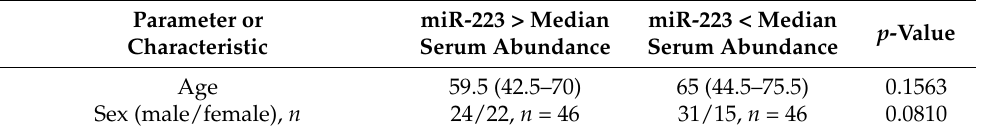
Table 1. Cont. Parameter or miR-223 > Median miR-223 < Median p -Value Characteristic Serum Abundance Serum Abundance Age 59.5 (42.5–70) 65 (44.5–75.5) 0.1563 Sex (male/female), n 24/22, n = 46 31/15, n = 46 0.0810 Circulating cell-free miR-223 was quantified in the serum of CAP patients, relative to that of healthy subjects. Median relative abundance of miR-223 in the serum (0.6455) was determined following normalization to circulating miR-24. Data displayed in median with 25–75% interquartile range, except for sex of enrolled patients. Clinical data were not available for all patients: CRP (90/92), blood leukocytes (89/92), segmented neutrophils (39/92). Mann-Whitney U test was performed to analyze statistical significance. CRP: C-reactive protein.